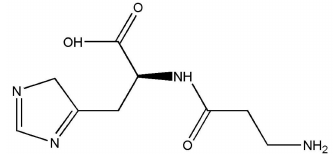
Figure 1. The molecular structure of L-carnosine.